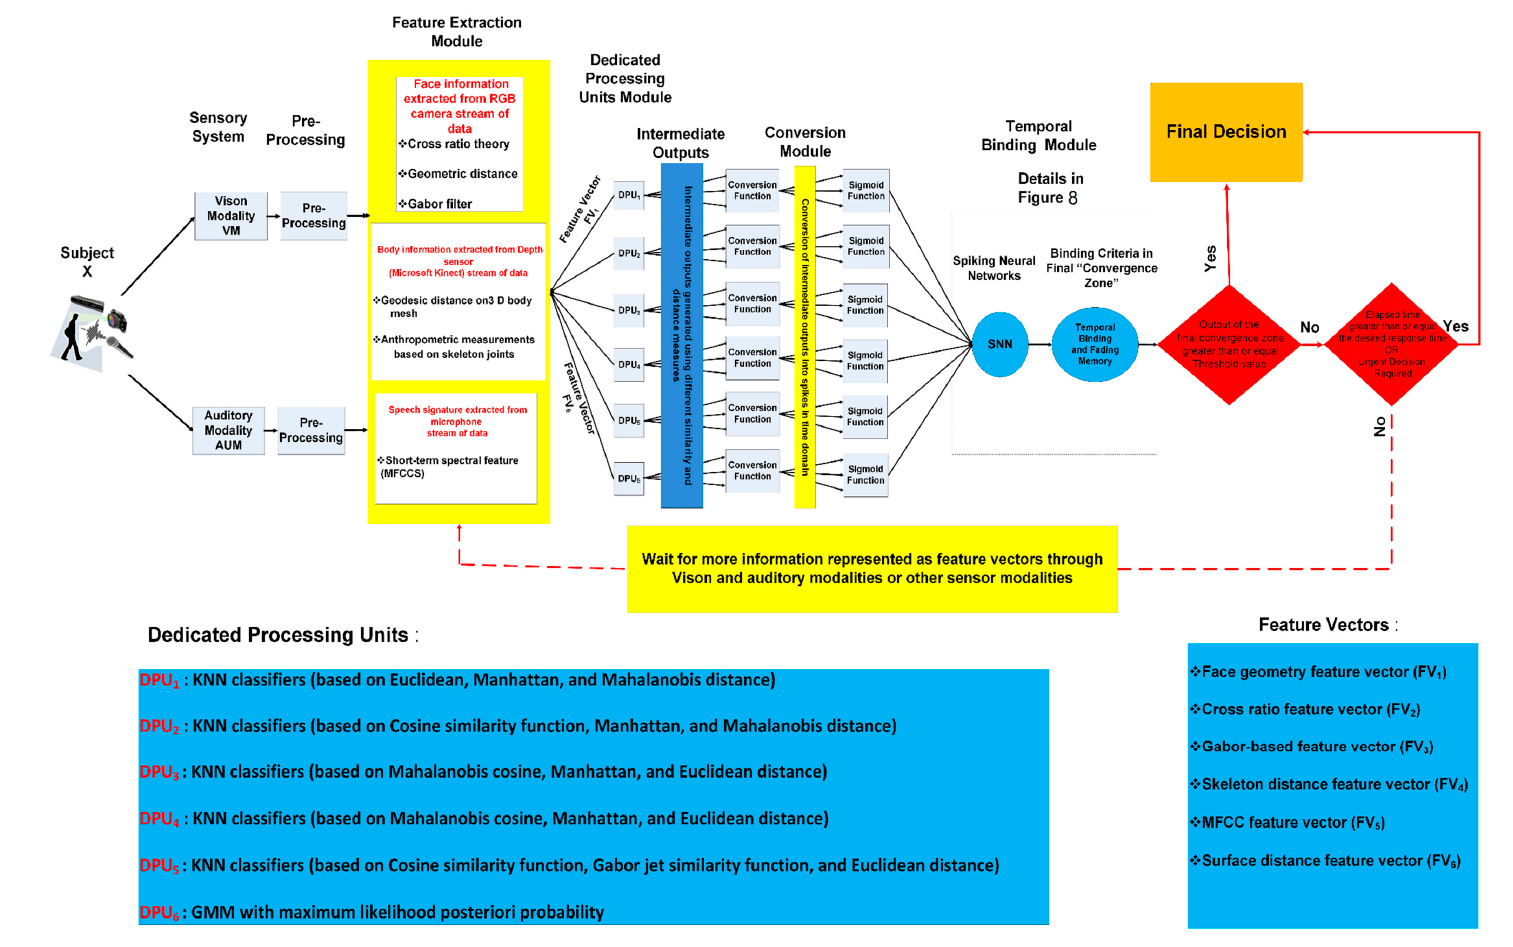
Figure 2. Sophistication of the proposed framework for person recognition task in social settings. DPU: Dedicated Processing Unit; KNN: K-Nearest Neighbors; GMM: Gaussian Mixture Models.